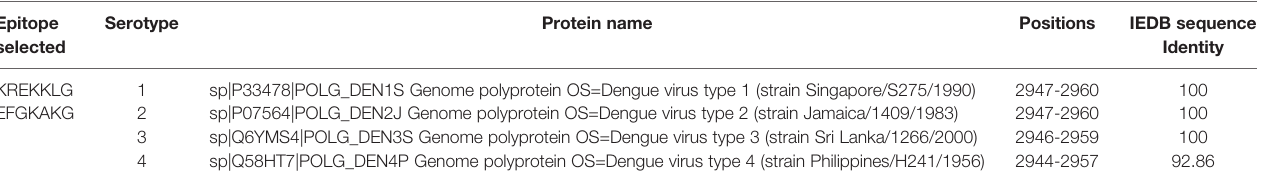
TABLE 2 | Selected conserved epitope peptide for synthesis. Epitope